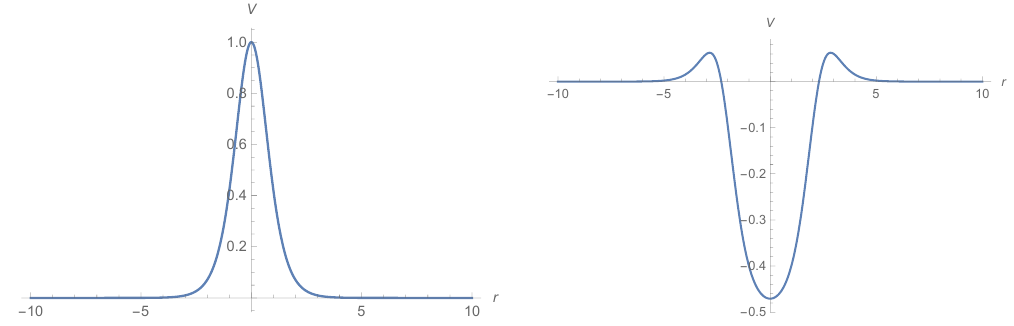
Figure 18 . On the left: the potential for s (1 (cid:0) s ) = 1 = 4 ; B = 1 = 2. On the right: the potential for s (1 (cid:0) s ) = 1 = 4 ; B = 1 = 100. There exist negative energy bound states of the (cid:13)uctuation equation in case B < 1 =